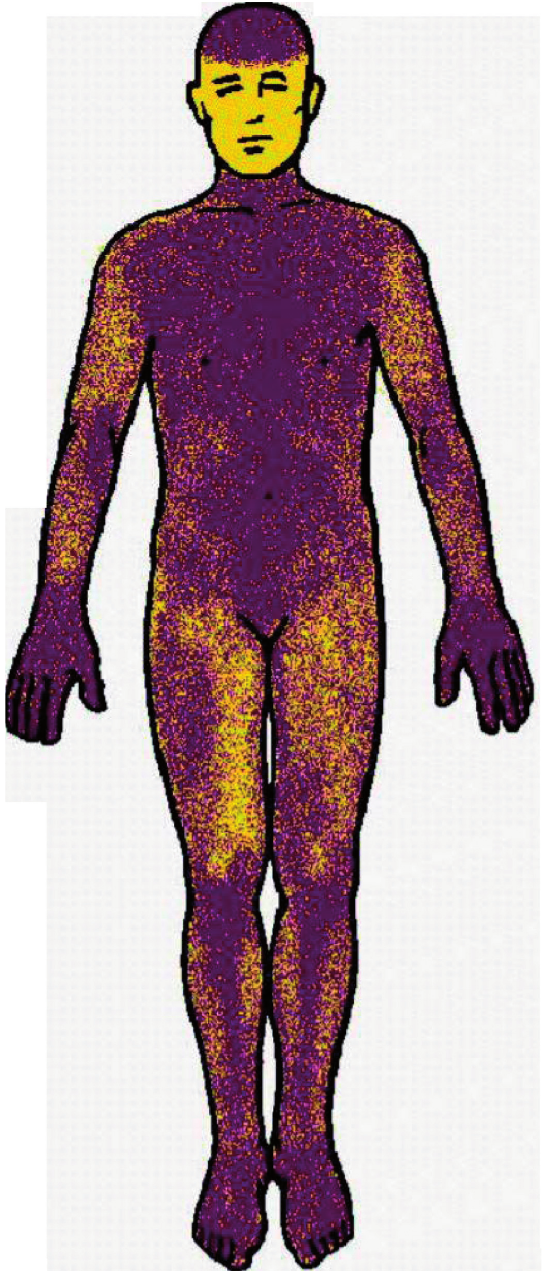
Figure 2: Thermoregulatory Sweat Test. Skin areas in yellow in- dicate reduced or absent sweat output consistent with small fiber